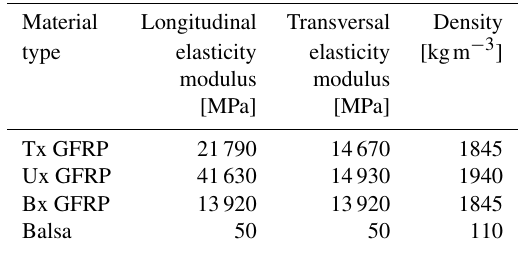
Table 5. Mechanical properties of the materials of the blade of the 10MW machine.